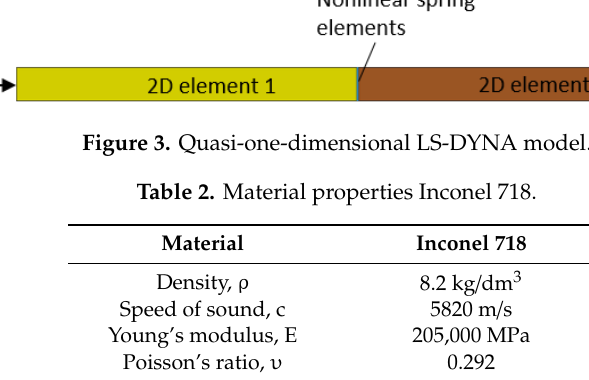
Figure 3. Quasi-one-dimensional LS-DYNA model.